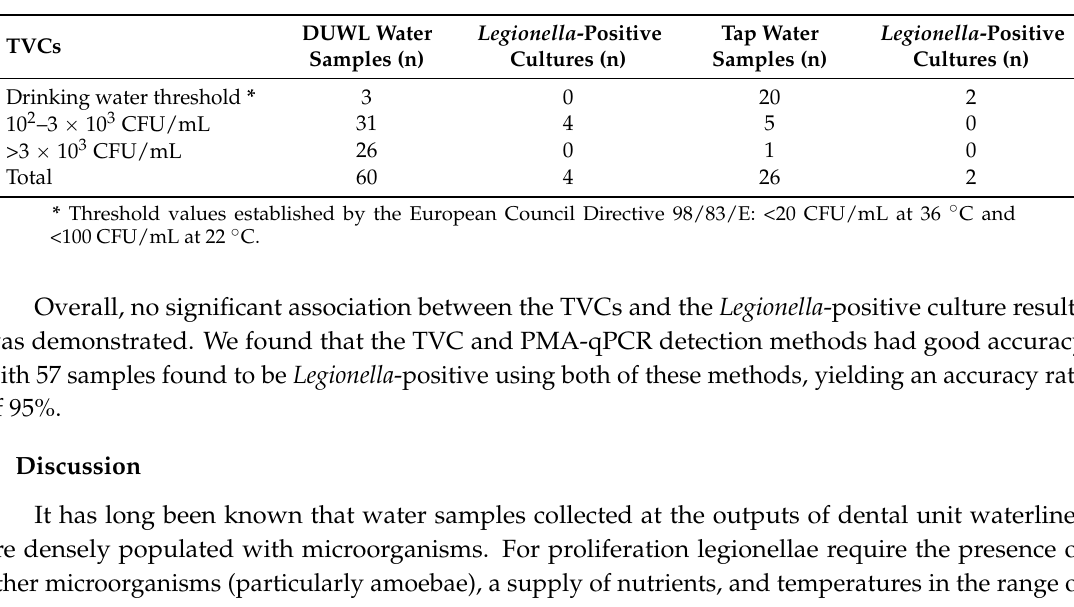
Table 4. Relationship between Legionella- positive cultures and the